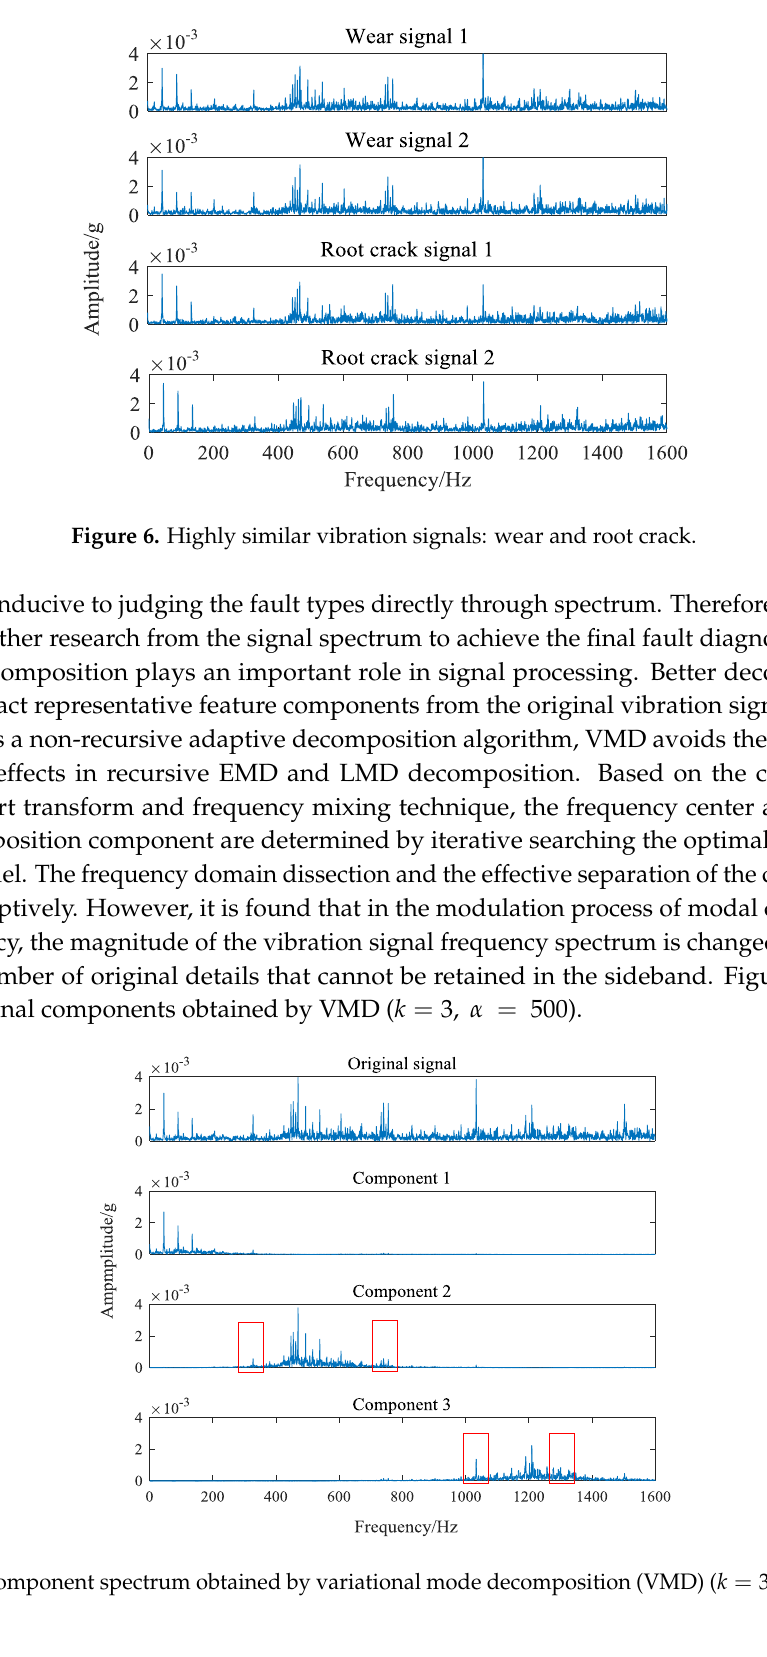
Figure 7. Component spectrum obtained by variational mode decomposition (VMD) ( k = 3, α = 500 ).